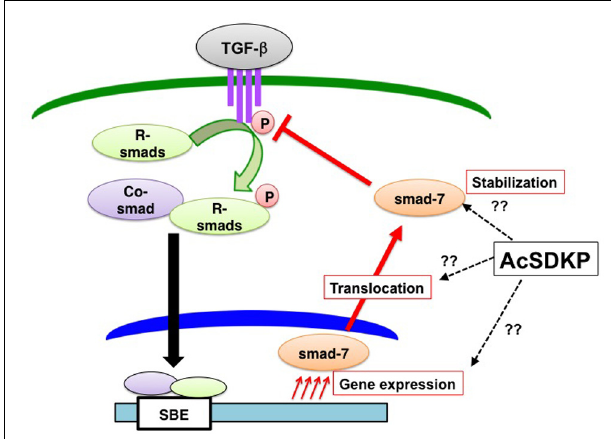
FIGURE 5 |AcSDKP is an anti-TGF- β /Smad peptide. OnceTGF- β binds to TGF- β receptors on the cell membrane, theTGF- β andTGF- β -receptor interaction induces phosphorylation of receptor-regulated (R)-Smads. Phosphorylated R-Smads interact with the common (co)-Smad in the cytoplasm.These Smad heterodimers in the nucleus then bind to the genomic promoter region of DNA, which is called the Smad-binding element (SBE). AcSDKP may induce Smad7 gene expression, protein stabilization, or translocation from the nucleus of cells to the cytoplasm as well as inhibit phosphorylation of R-Smads byTGF- β receptors. However, detailed mechanisms are not yet